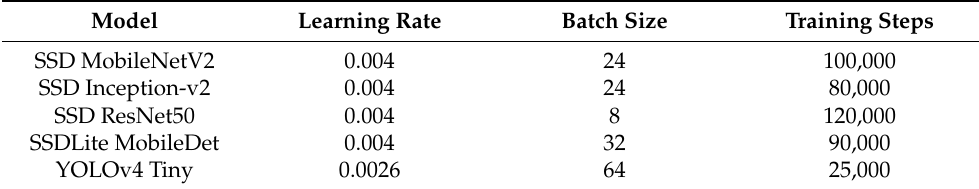
Table 3. Training details of the DL